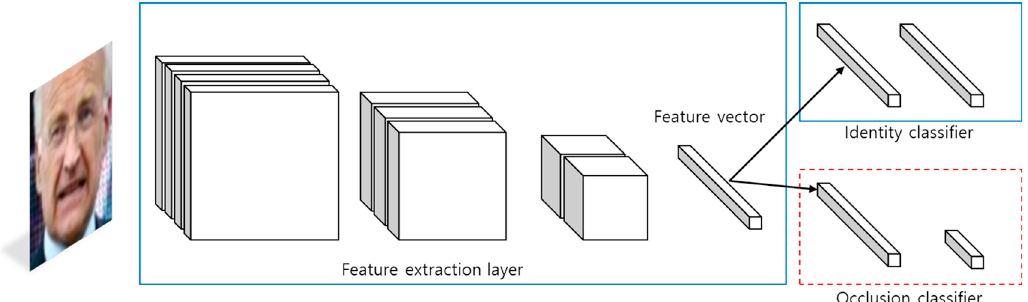
Figure 6. Identity recognition network and occlusion classifier. The blue solid line represents the existing identity recognizer, and the red dotted line represents the added occlusion classifier.